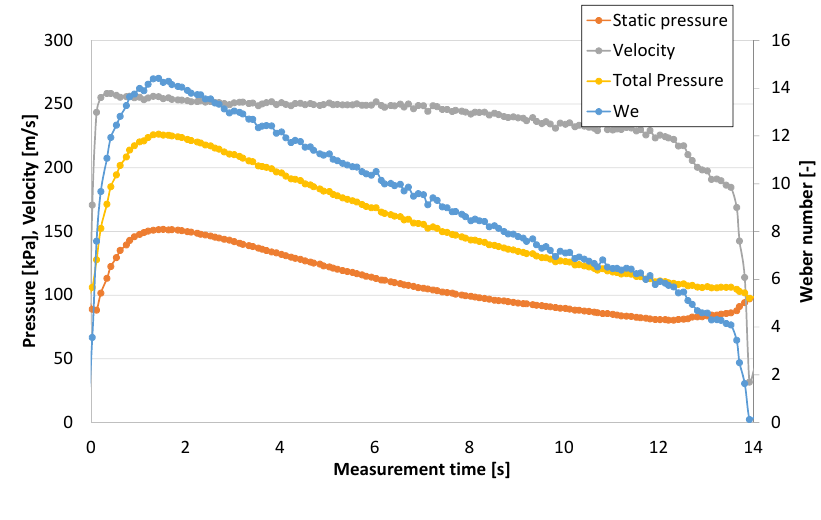
Figure 7. Profile of the velocity and pressures during the